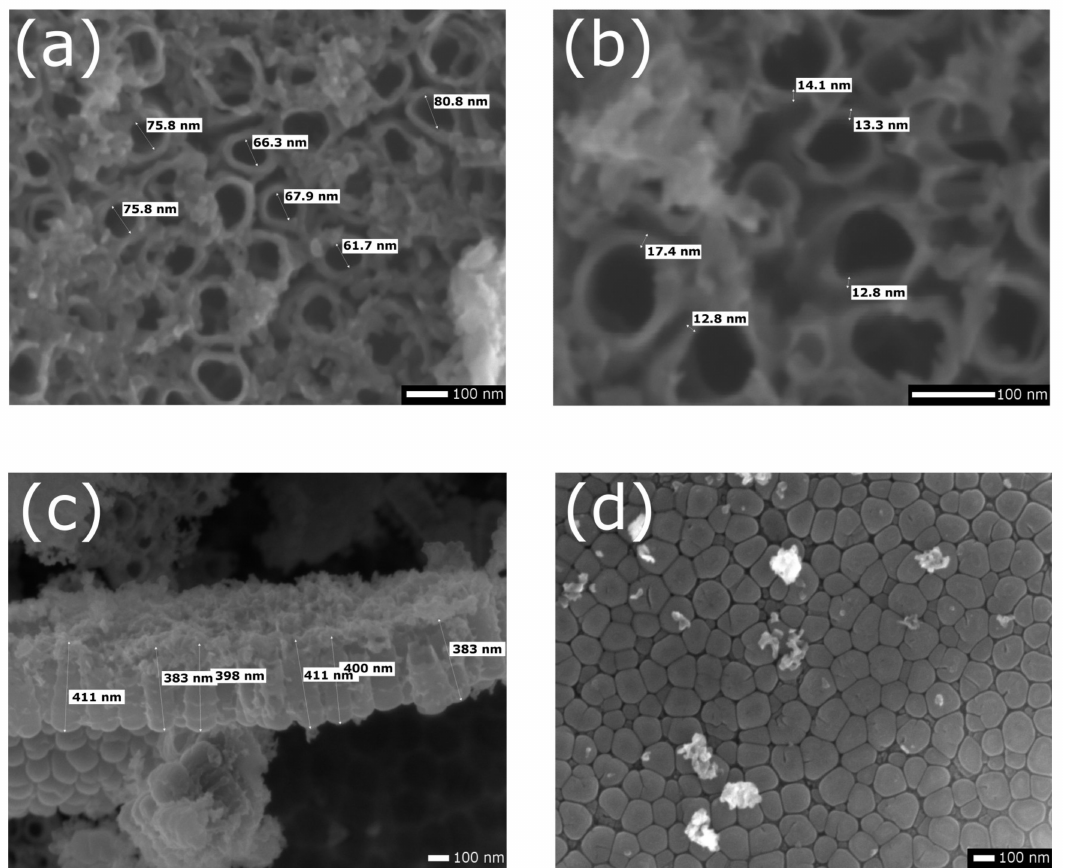
Figure 2. SEM images of TiO 2 nanotubes on titanium grade 2 obtained by electrochemical anodization at 20 V for 20 min: ( a ) top view with inner diameter measurements of nanotubes; ( b ) top view with nanotube wall thickness measurements; ( c ) cross-sectional view with nanotube length measurements; and ( d ) bottom view of